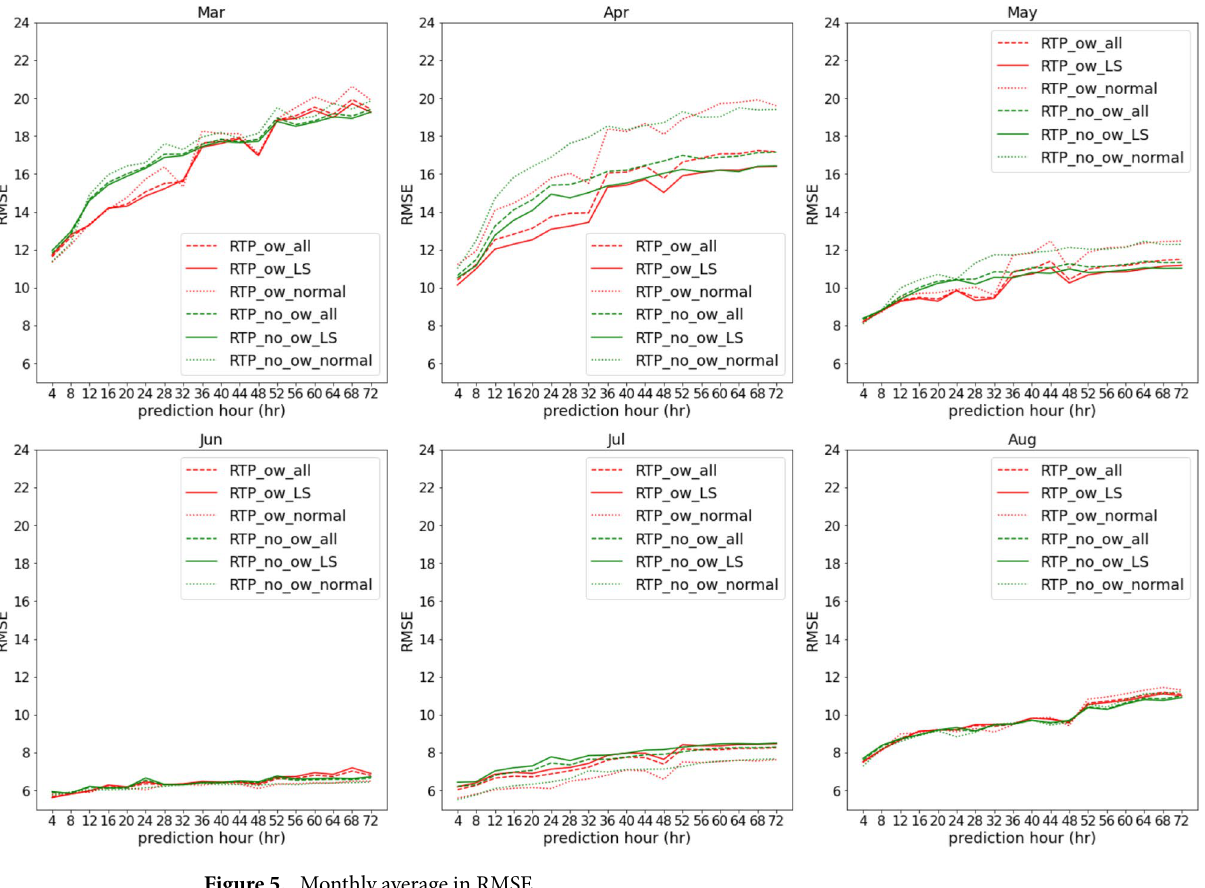
Figure 5. Monthly average in